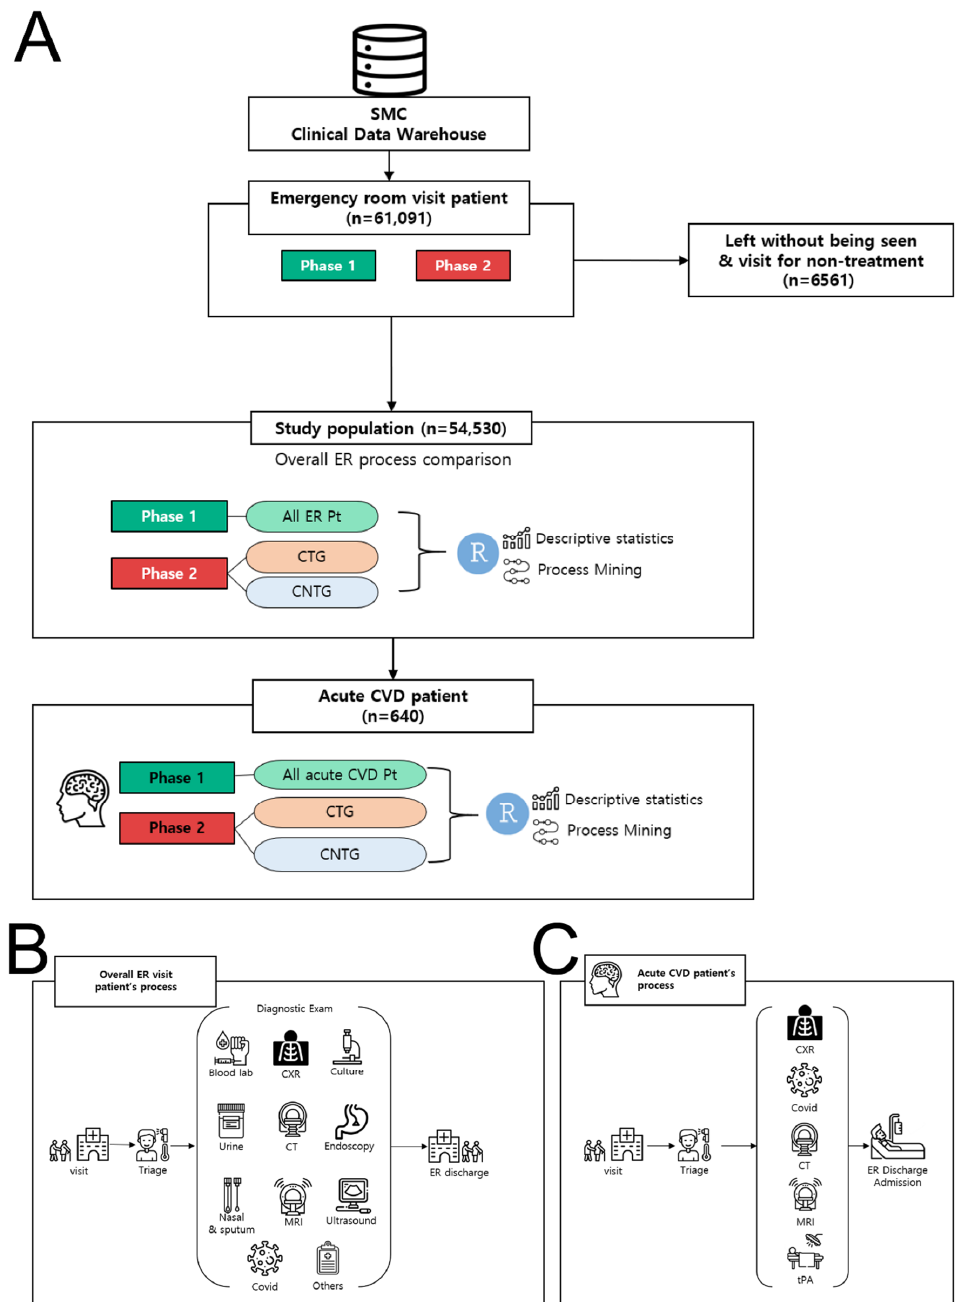
Figure 1. Flowchart of the study. ( A ) Phase 1 included patients who visited the Emergency Department (ED) from 1 February 2019 to 31 July 2019. Phase 2 included patients who visited the ED from 1 February 2020 to 31 July 2020. Phase 2 was divided into the “coronavirus disease 2019 (COVID-19) Tested Group” (CTG) and “COVID-19 Not Tested Group” (CNTG). CTG included patients who underwent the COVID-19 PCR test, and CNTG included patients who did not undergo the COVID-19 PCR test. ( B) Process analysis of all overall ED patients. ( C ) Process analysis of patients with acute cerebrovascular disease. COVID-19: coronavirus disease 2019; ED: emergency department, SMC: Samsung Medical Center, ER: Emergency Room, CTG: COVID-19 tested group, CNTG: COVID-19 not tested